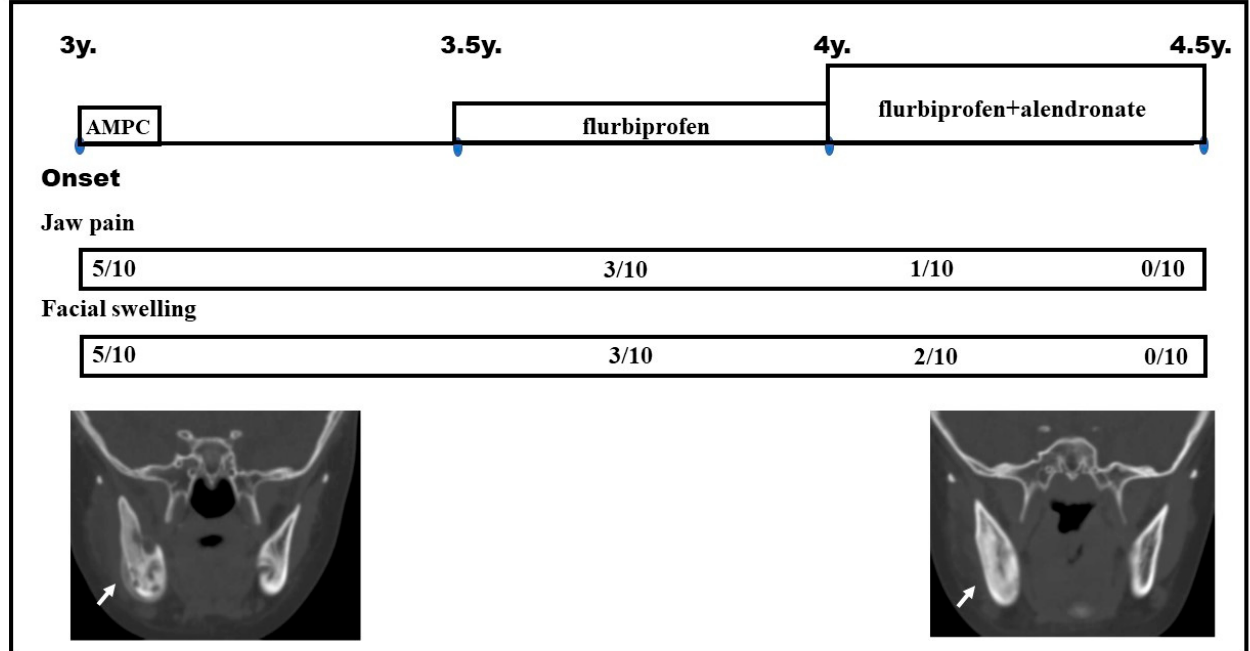
Table 1. Laboratory